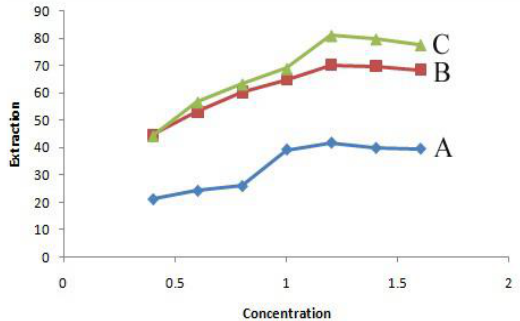
O nanosorbents, (B) BKC-coated Fe 3 4